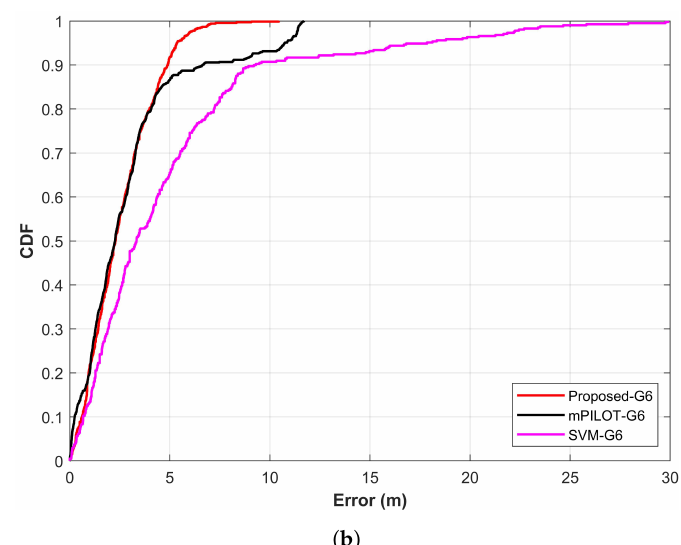
Figure 15. Comparison of proposed approach with mPILOT [39] and SVM: ( a ) Galaxy S8 results and ( b ) LG G6 results. Table 5. Results statistics for single vs. multiple features based